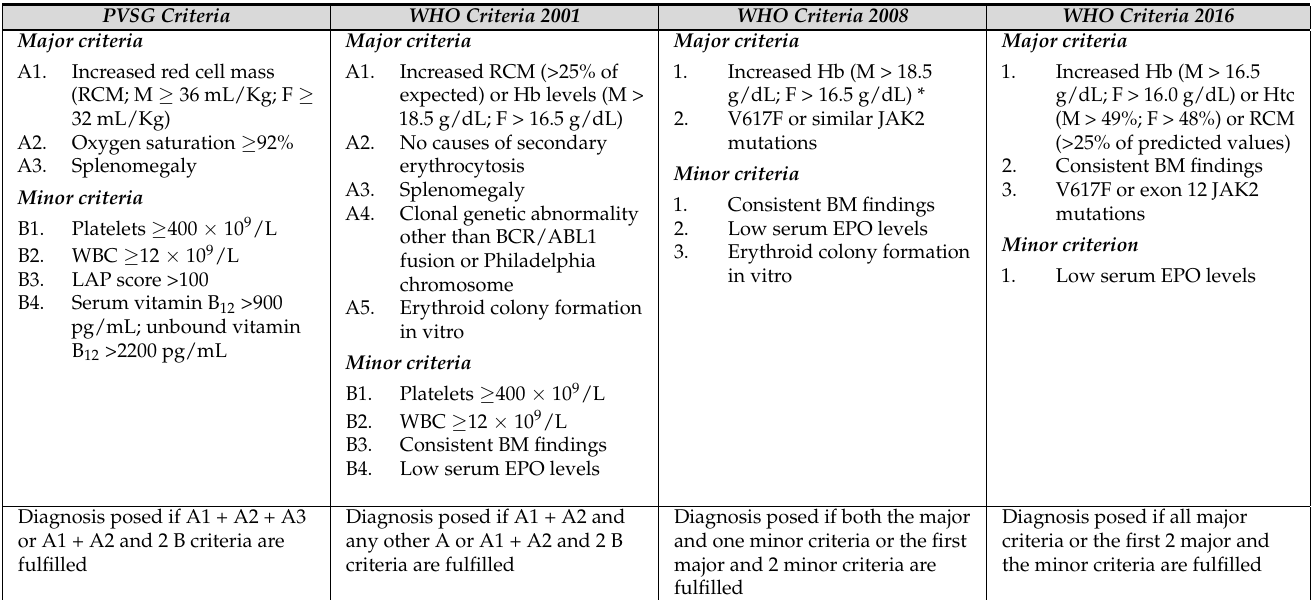
Table 2. Evolution of diagnostic criteria for Polycythemia